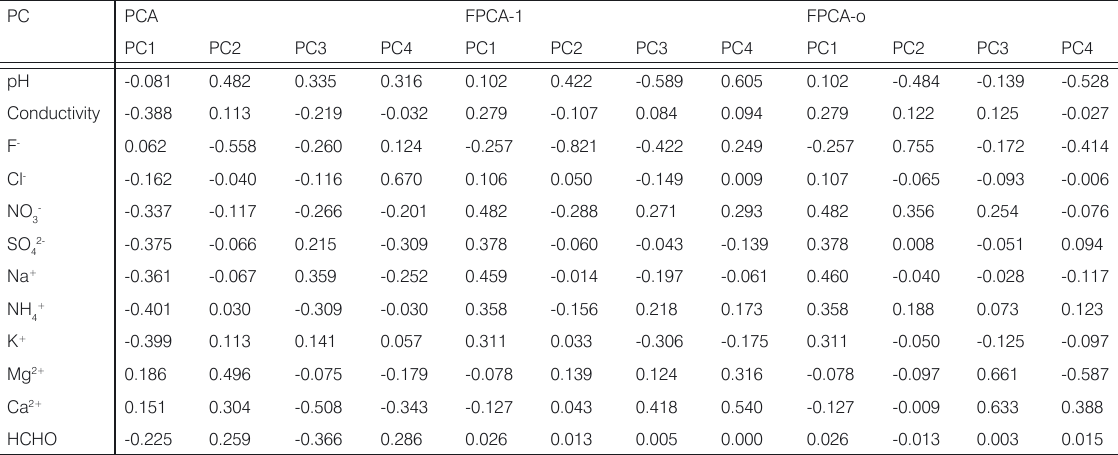
Table 6. Comparative loadings considering the first four principal